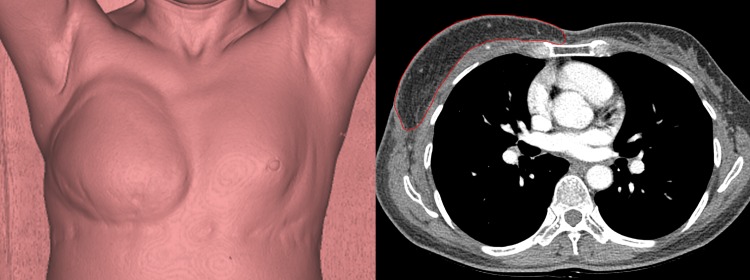
Volumetric analysis.(A) Three-dimensional reconstructed image of chest computed tomographic study. (B) Outline of abdominal flap was manually marked in each scan image.